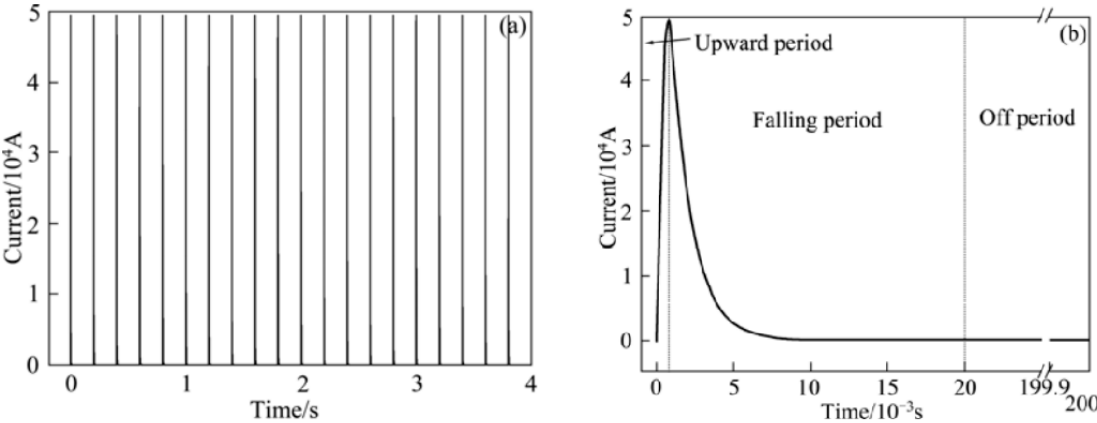
Figure 9. Variation of pulsed electricity in coil: ( a ) 20 whole periods of current; and ( b ) pulse’s profile in one period of pulse [22].